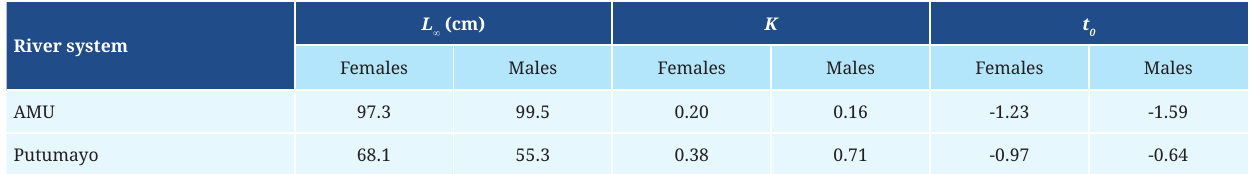
TABLE 3 | Standard length-at-age for females and males of Pseudoplatystoma punctifer in the AMU system and Putumayo